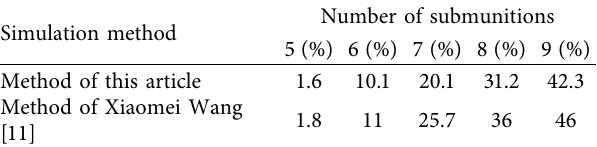
Table 4: Comparison of simulation results.